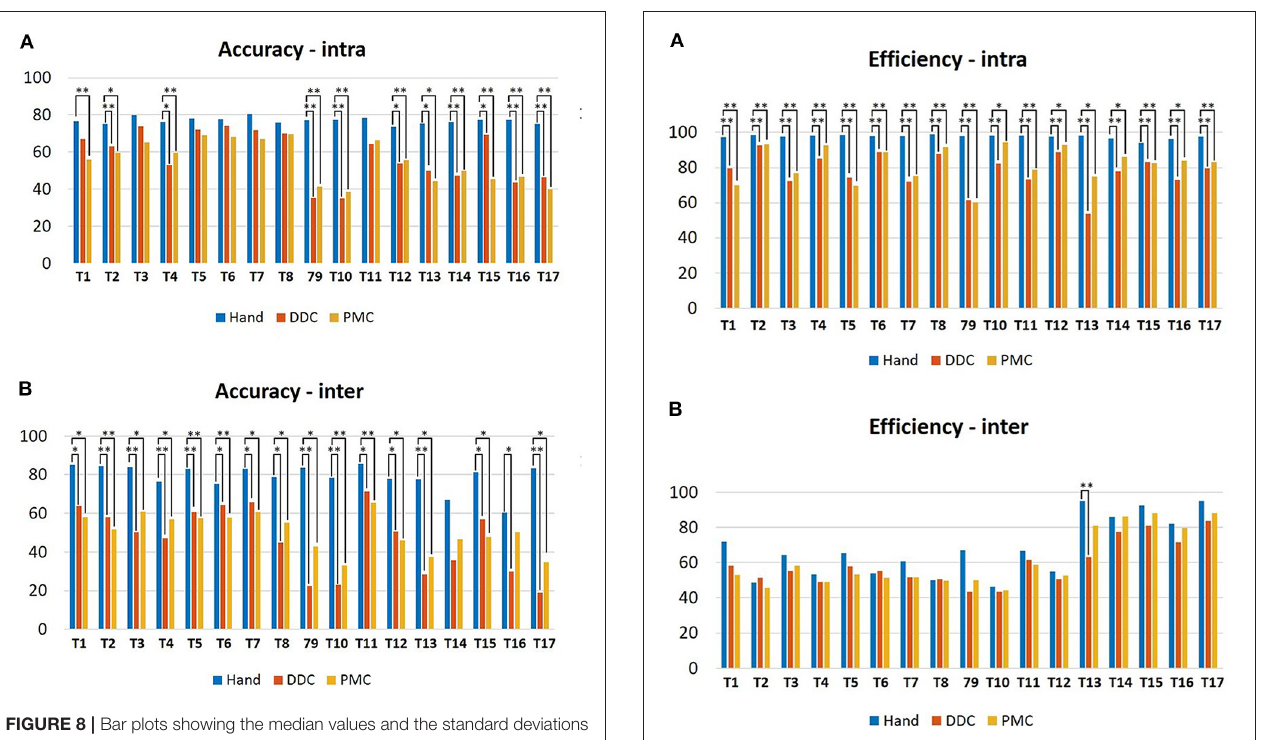
FIGURE 9 | Bar plots showing the median values and the standard deviations upon all the subjects of the (A) intra-subject efficiency and (B) inter-subjects efficiency indices obtained during the execution of the tasks in the three configurations tested. * p < 0.05 ** p <